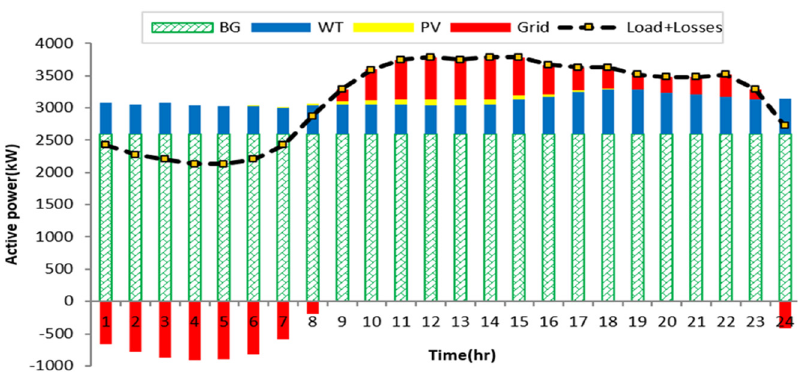
Figure 9. Results of the first MG operation without optimal control.